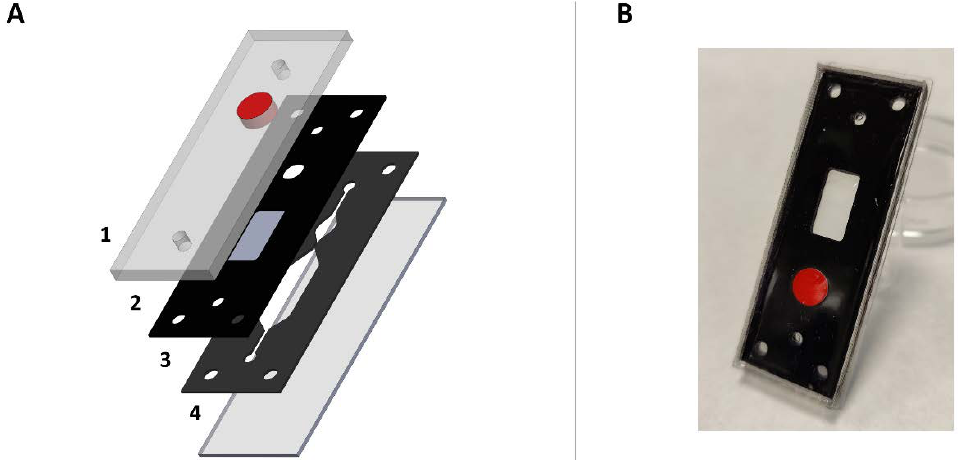
Figure 1. ( A ) 3D exploded view representation of the brain slice-on-a-chip, showing the microfluidic chamber the four layers that shape the chip: 1—polydimethylsiloxane (PDMS) block with two holes for inserting the tubing of the fluidic system, and with an integrated PTFE plug to allow needle puncture of the chip and maintain the chip’s tightness; 2—upper vinyl layer with polycarbonate membrane adhered to the underside; 3—lower vinyl layer through which the flow is perfused. Two compartments form this layout: a prechamber where the reagents are injected, acting as an air bubble trap, and the chamber which interacts with the tissue; 4—75 × 25 mm glass substrate. 2 and 3 present four holes in the corners for a correct overlapping between the vinyl sheets. ( B ) Picture of the final chip version employed for hippocampal slices culture.